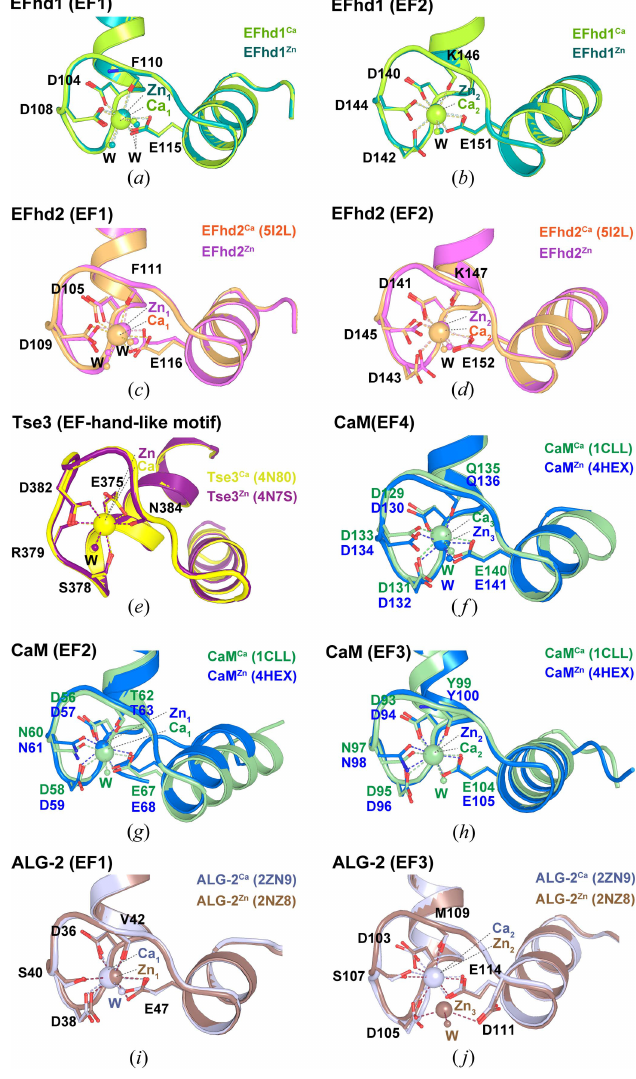
Figure 4 Structural comparison of Ca 2+ - and Zn 2+ -bound EF-hands among EFhd1, EFhd2 and other proteins. Detailed view of superimposed ( a ) EF-hand 1 (EF1) and ( b ) EF-hand 2 (EF2) in EFhd1 Ca and EFhd1 Zn . EFhd1 Ca and EFhd1 Zn are shown in lime green and teal, respectively. Detailed view of superimposed ( c ) EF1 and ( d ) EF2 in EFhd2 Ca and EFhd2 Zn . EFhd2 Ca (PDB entry 5i2l) and EFhd2 Zn are orange and magenta, respectively. Detailed view of the superimposed EF-hand-like motifs in ( e ) Tse3 Ca in yellow (PDB entry 4n80) and Tse3 Zn in purple (PDB entry 4n7s) and EF4 in ( f ) CaM Ca in pale green (PDB entry 1cll) and CaM Zn in blue (PDB entry 4hex). Detailed view of superimposed ( g ) EF2 and ( h ) EF-hand 3 (EF3) in CaM Ca in pale green (PDB entry 1cll) and CaM Zn in blue (PDB entry 4hex). Detailed view of superimposed ( i ) EF1 and ( j ) EF3 of ALG- 2 Ca in silver (PDB entry 2zn9) and ALG-2 Zn in bronze (PDB entry 2zn8). In all panels, the residues for Zn 2+ coordination are represented in stick form, and Zn 2+ coordination is represented by dashed lines.